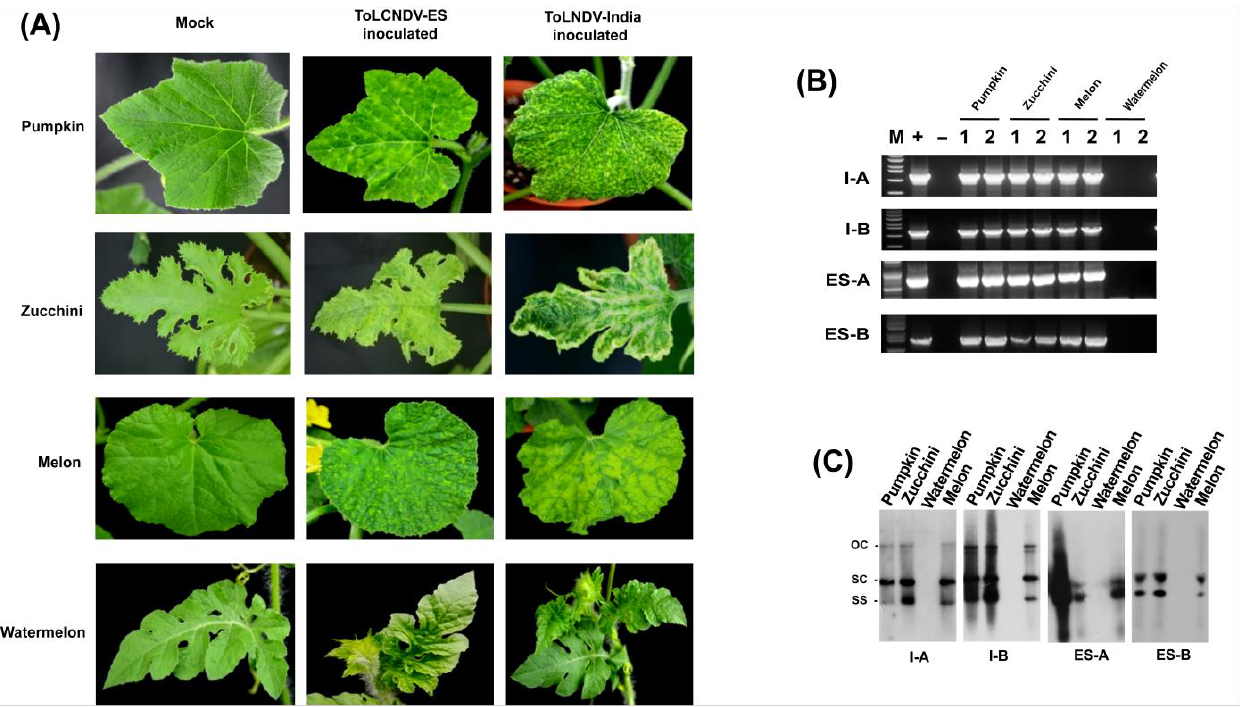
Figure 4. Infectivity of two ToLCNDV isolates in cucurbit plants after three weeks post inoculation. ( A ) Phenotypes of inoculated plants on different cultivars of pumpkin, zucchini, melon, and wa- termelon. Infected plants of all test species except watermelon showed curling and yellow mosaic symptoms. ( B ) ToLCNDV detection results by PCR. Lane M: ladder; Lane +: positive control; Lane −: negative control. (1) Korean cultivar, (2) Italian cultivar. ( C ) Southern blot results.